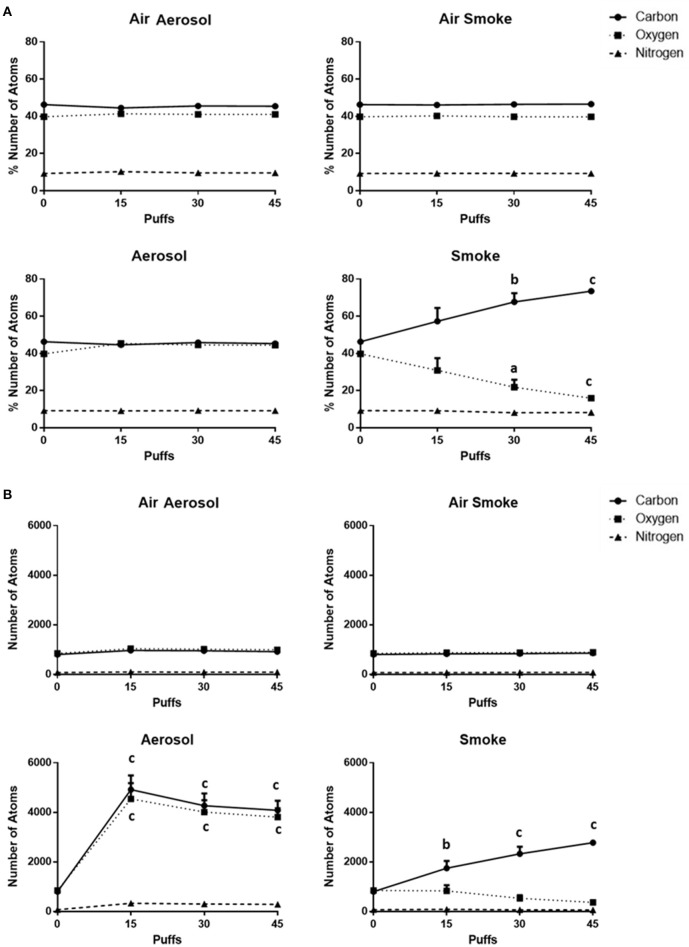
(A) Percentages of and (B) total numbers of (based on sampling area) C, O, and N atoms on MCE membranes after exposure to 0, 15, 30, and 45 puffs of air, ECIG-generated aerosol and smoke. Data points given as mean ± standard error of the mean. Comparisons between 0 puffs (control) and 15, 30, or 45 puffs where a = p < 0.01, b = p < 0.005 and c = p < 0.001.